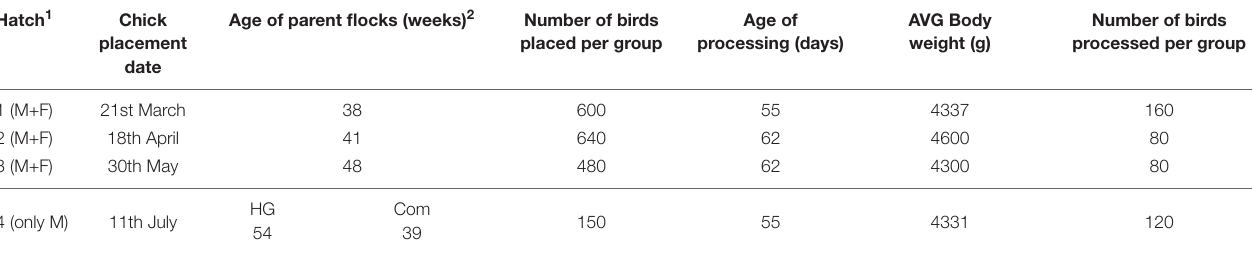
TABLE 3 | Placement date, parent stock age, broiler age and average (AVG) bodyweight per hatch and number of birds processed and assessed for wooden breast myopathy per group in study 2 comparing commercial Ross 708 broilers and high generation Ross 708 broilers. Hatch 1